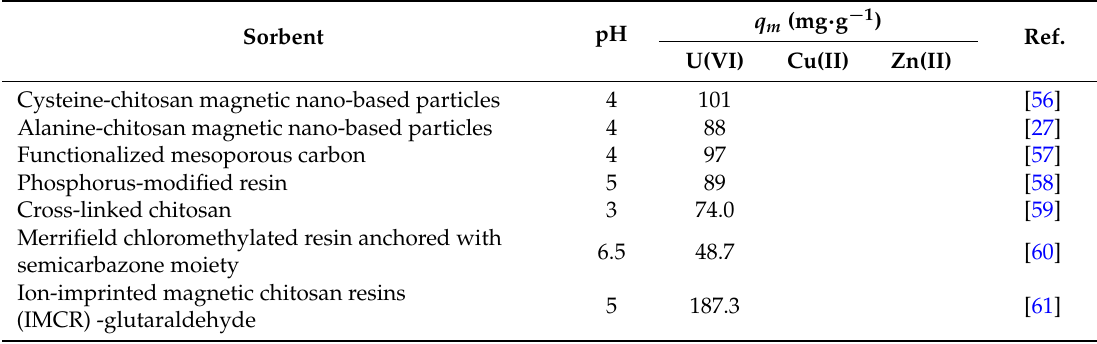
Table 4. Sorption properties for U(VI), Cu(II), and Zn(II) by different